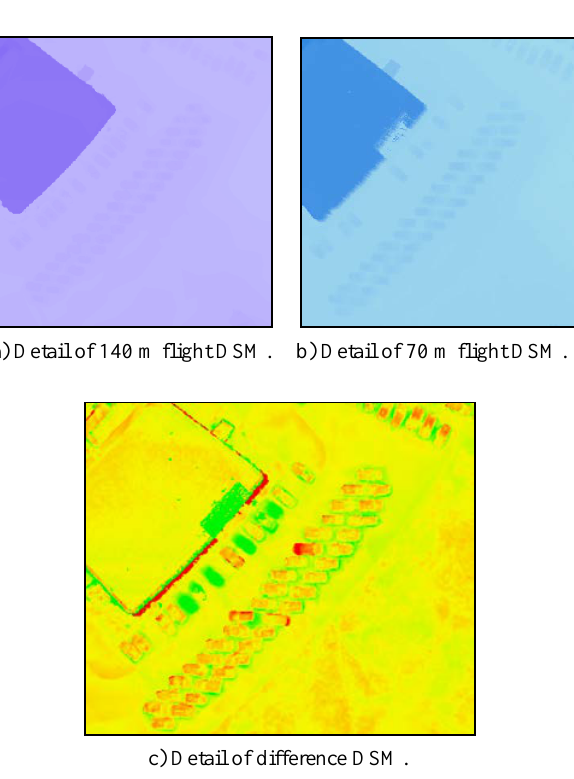
Figure 8 – DSM of 70 m flight and GPS survey locations.